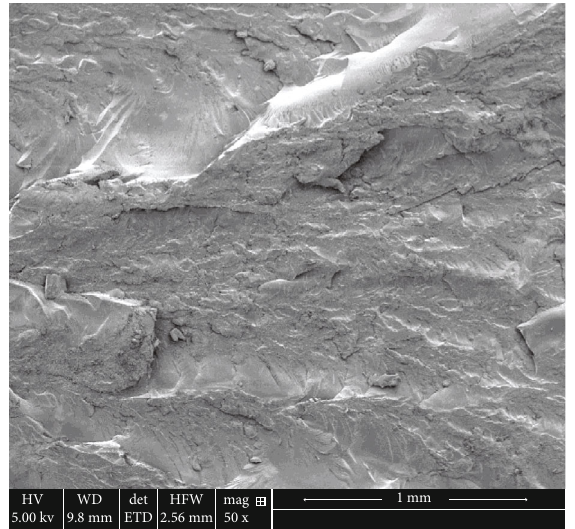
Figure 17: Fracture surfaces due to tensile failure in a 1.5 wt.% MWCNT-reinforced epoxy composite at room